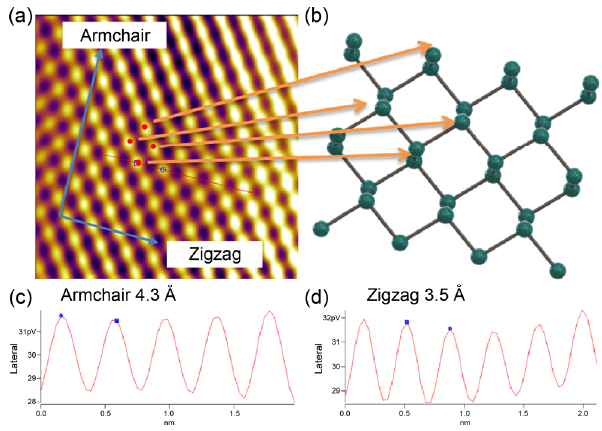
Fig. 6 Corresponding relation between the measured and calculation value: (a) the atomic image of BP; (b) the schematic diagram of BP; (c) and (d) interatomic spacing of armchair and